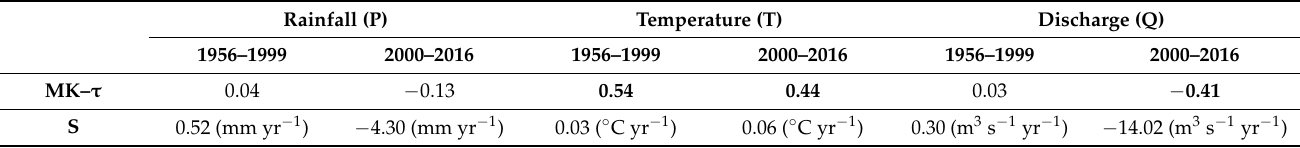
Table 1. Trend analysis on hydro-meteorological variables of the Lhasa River Basin. MK– τ represents Mann–Kendall’s trend at p = 0.05 (bold values are significant at p -value), and S represents the Sen’s slope estimator for change. The negative sign indicates a